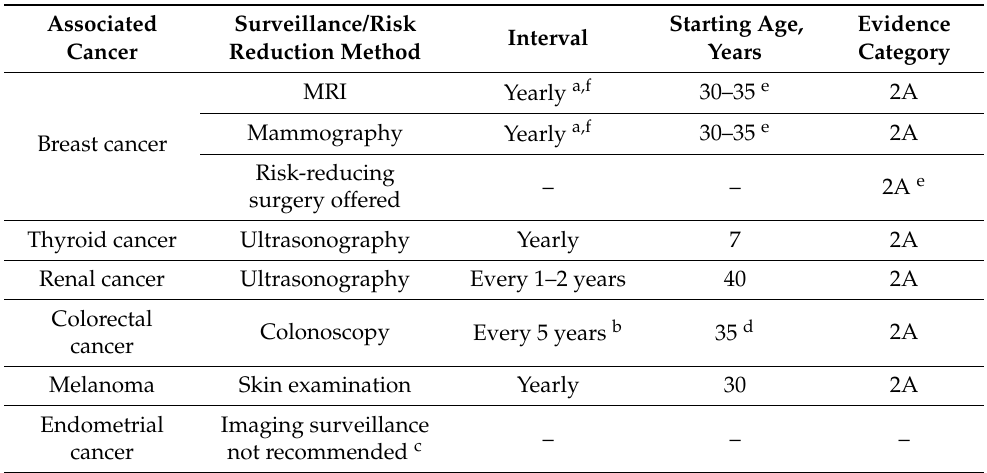
Table 3. National Comprehensive Cancer Network (NCCN), v2.2021, cancer screening recommenda- tions for patients with Cowden